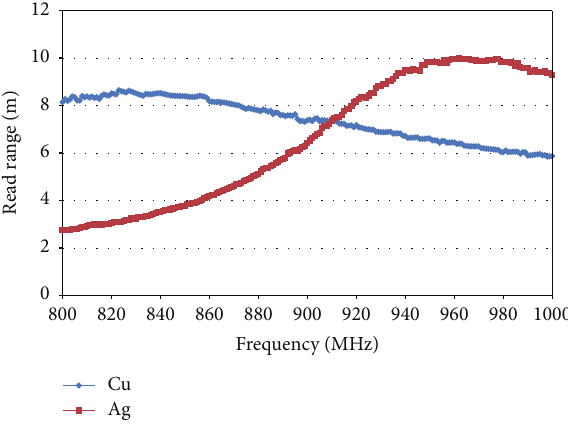
Figure 8: Measurement results for copper and silver